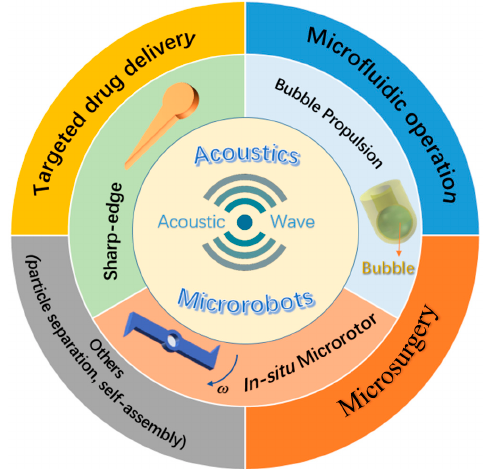
Figure 1. Classifications and applications of acoustics-actuated microrobots.